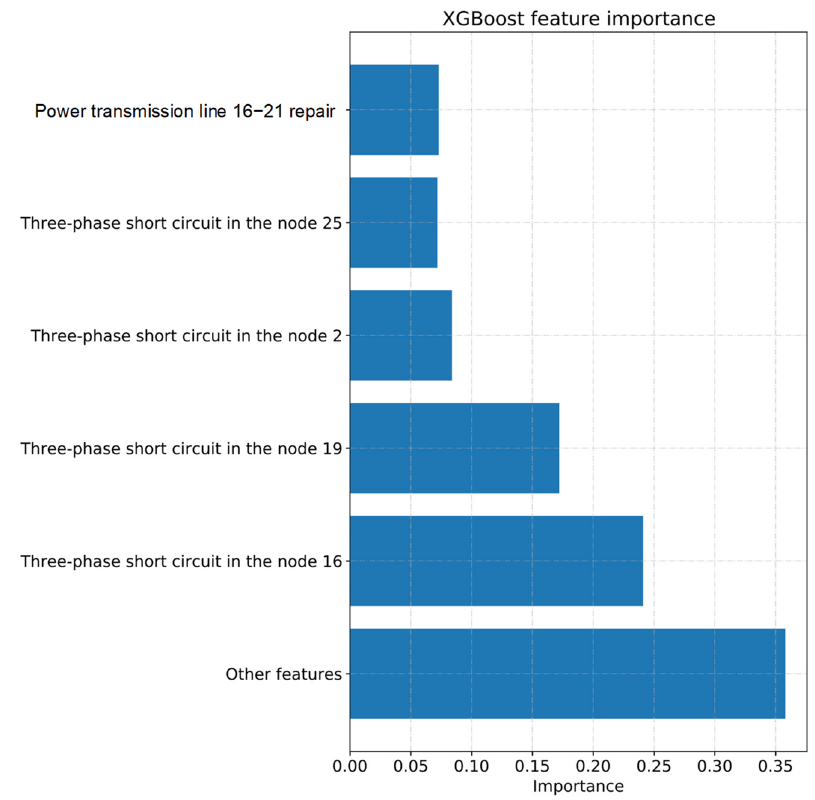
Figure 4. XGBoost feature importance.